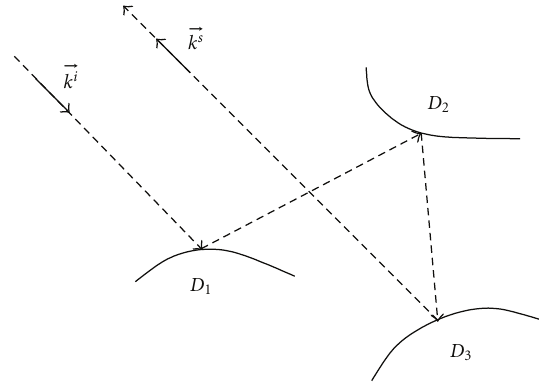
Figure 2: Example of ray tracing for multiple e ff ects.